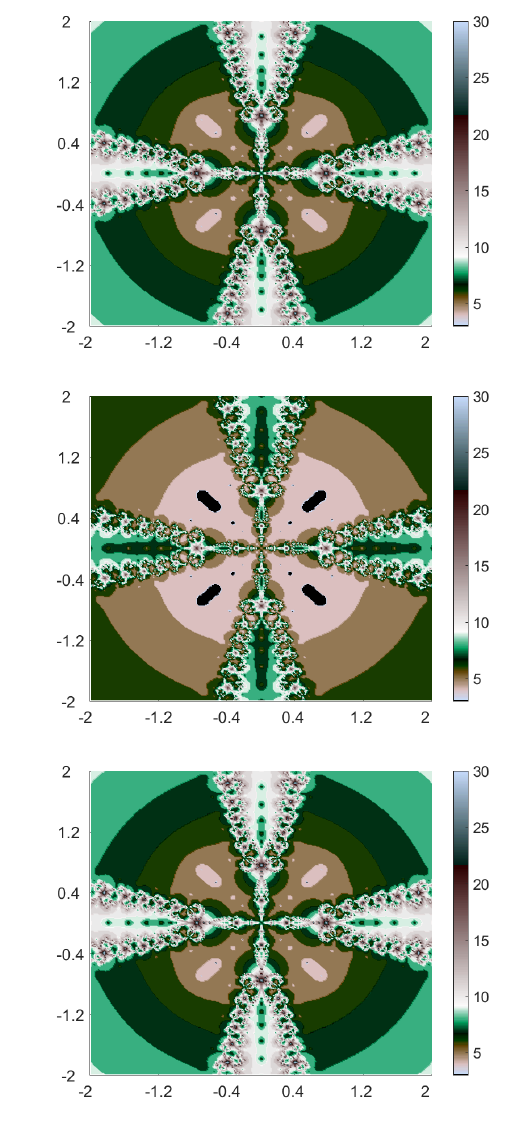
Figure 4. Visualisation of effects of control sequence on polynomiographs for RK iteration with s-convexity, p ( z ) = z 4 + 1: Case I ( Top Left ); Case II ( Top Right ); Case III ( Middle Left ); Case IV ( Middle Right ); Case V ( Bottom Left ), and Case VI ( Bottom Right